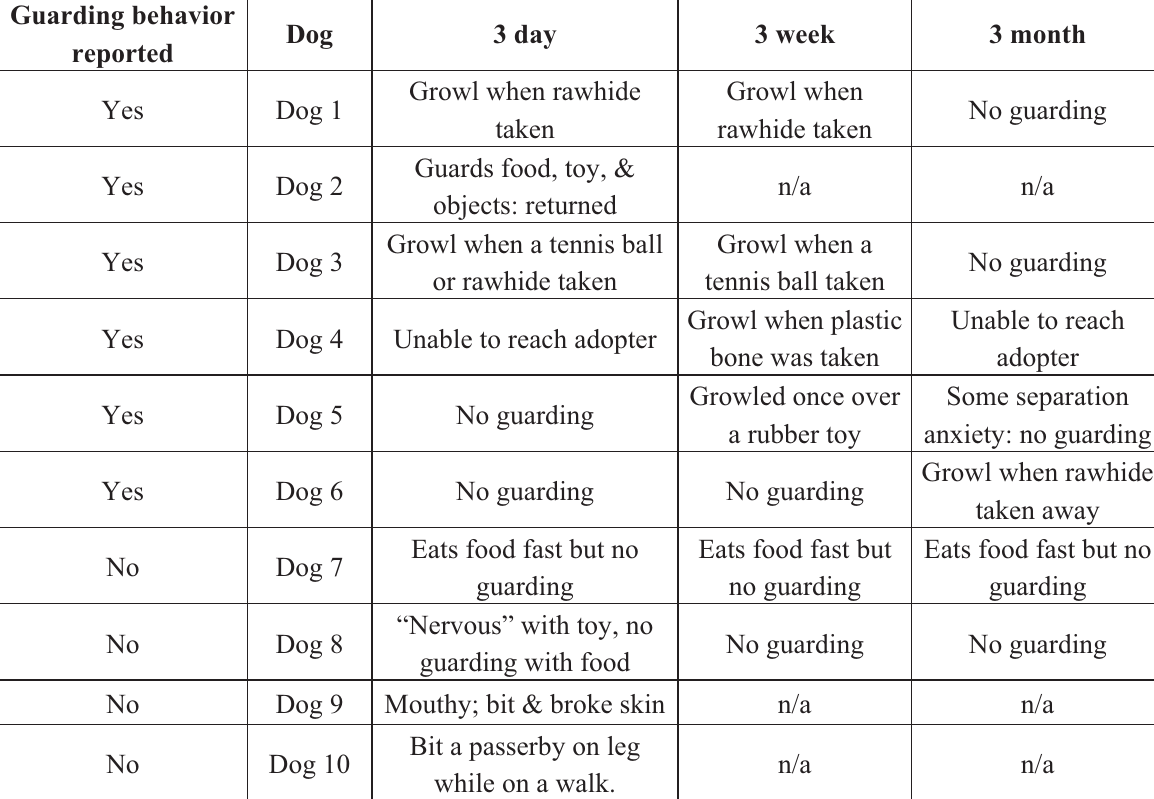
Table 3. All dogs that were reported to have any concerning behavior in-home during follow-up (both guarding and non-guarding behaviors are